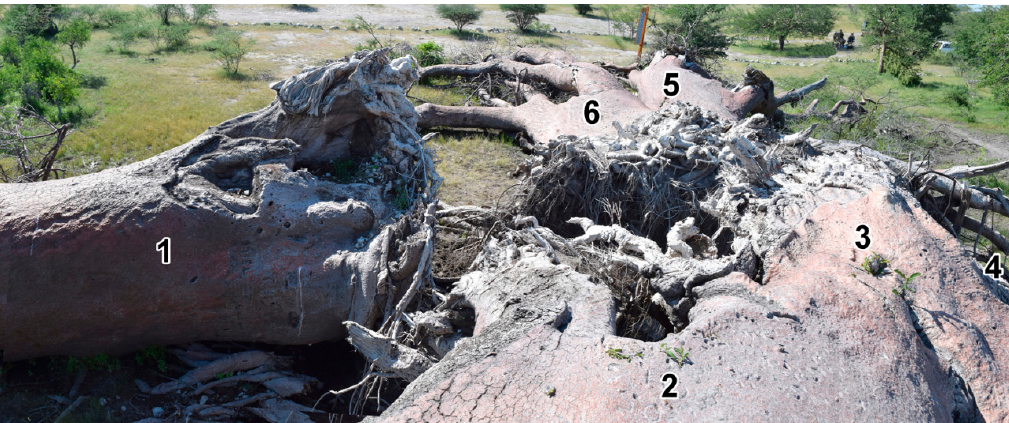
Figure 3. Dramatic photograph of the fallen Chapman baobab taken from stem 2, with stem numbering. The tree lies on the ground with unbroken stems and branches.